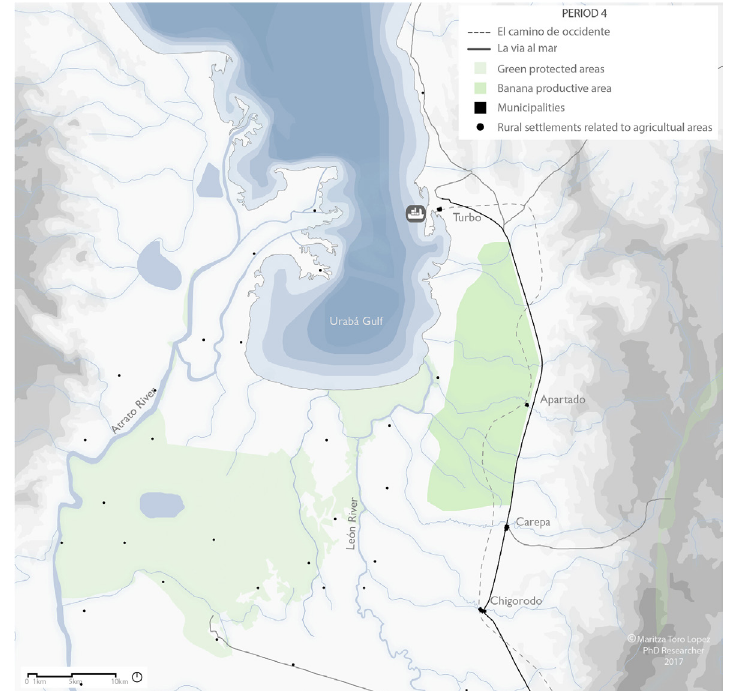
Fig. 5 . Period 4: Designing a regional highway La vía al mar